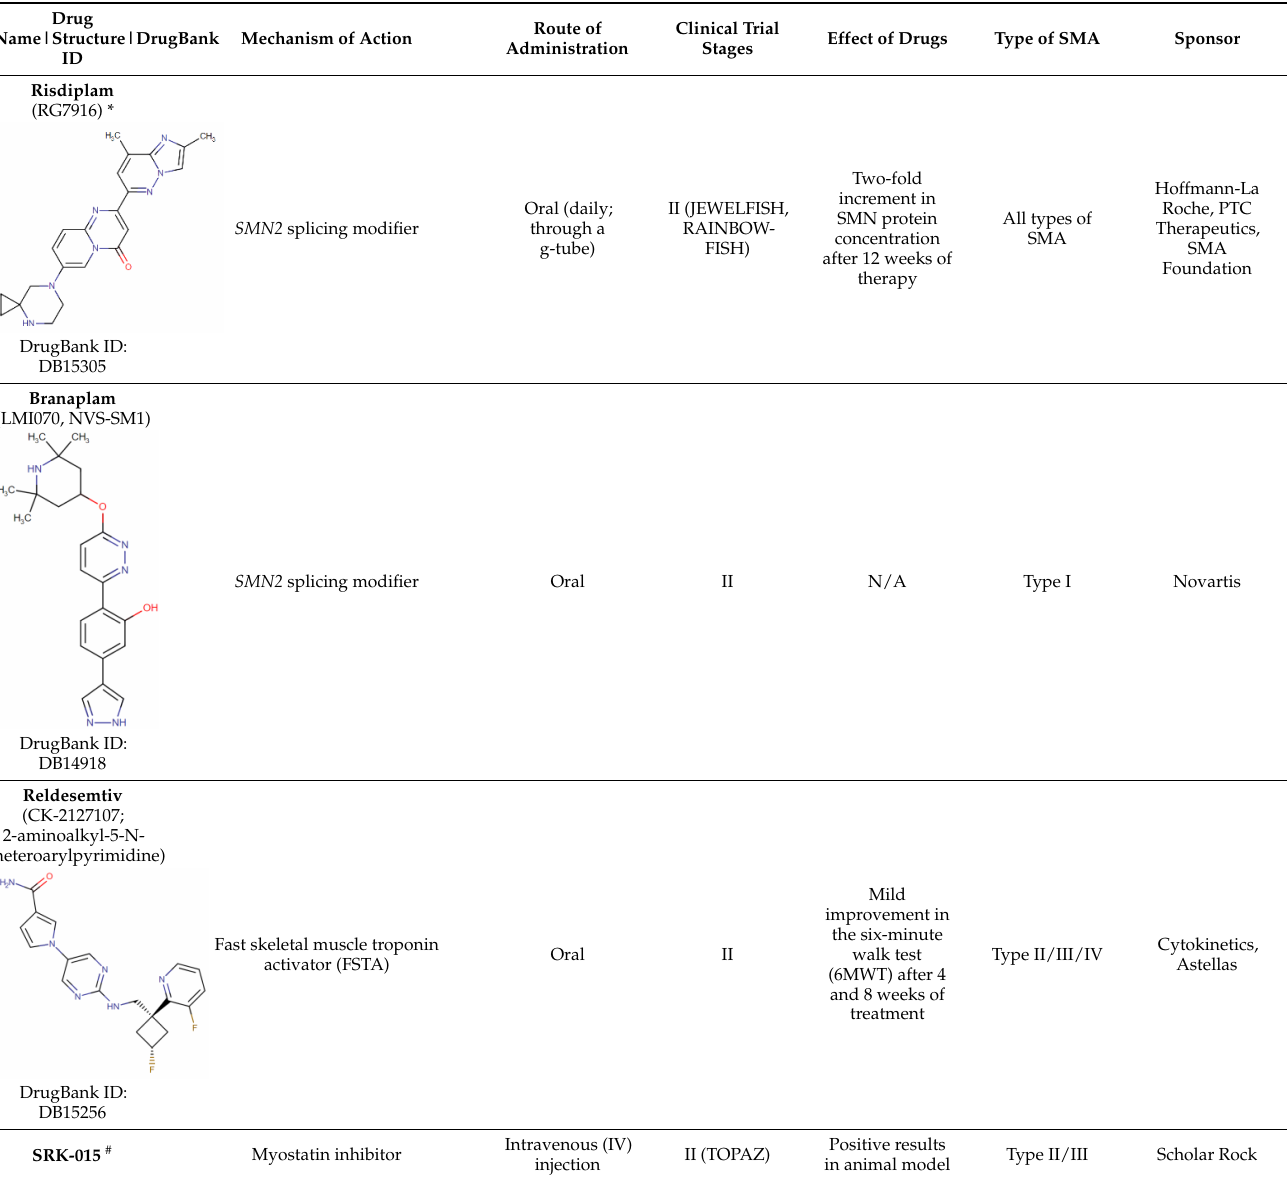
Table 1. Therapeutic approaches in spinal muscular atrophy: clinical trial